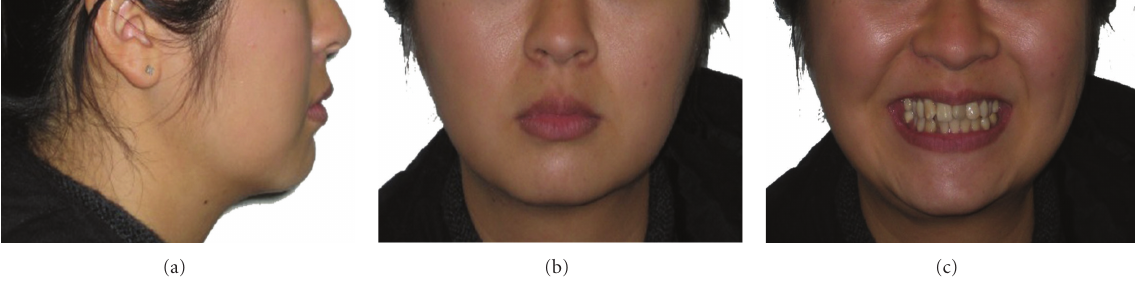
Figure 1: Pretreatment extraoral photographs.